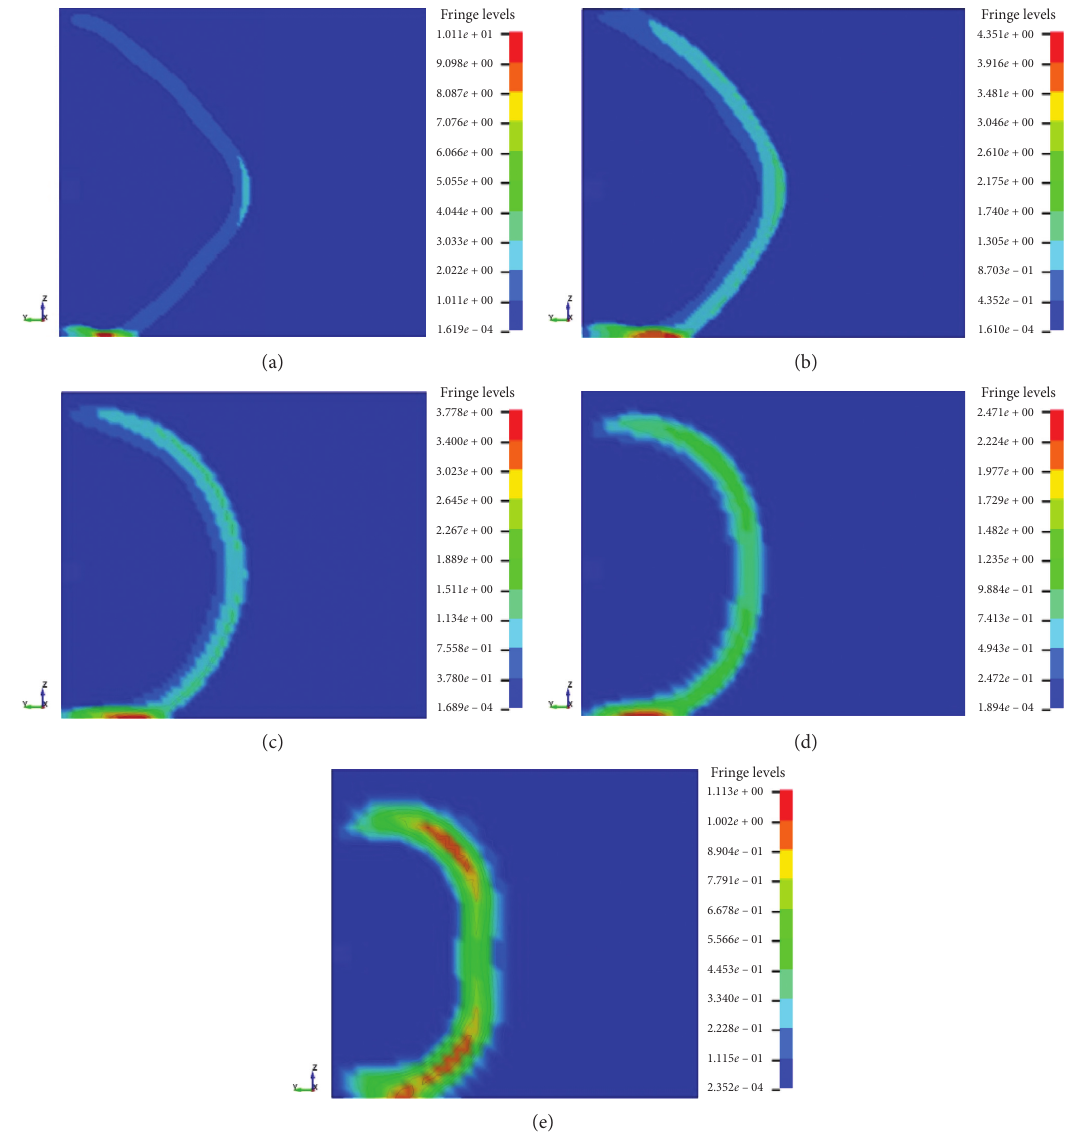
Figure 9: Results of presimulation with different element sizes (0.5ms after explosion). (a) Element size of 10mm. (b) Element size of 20mm. (c) Element size of 30mm. (d) Element size of 40mm. (e) Element size of 60mm.